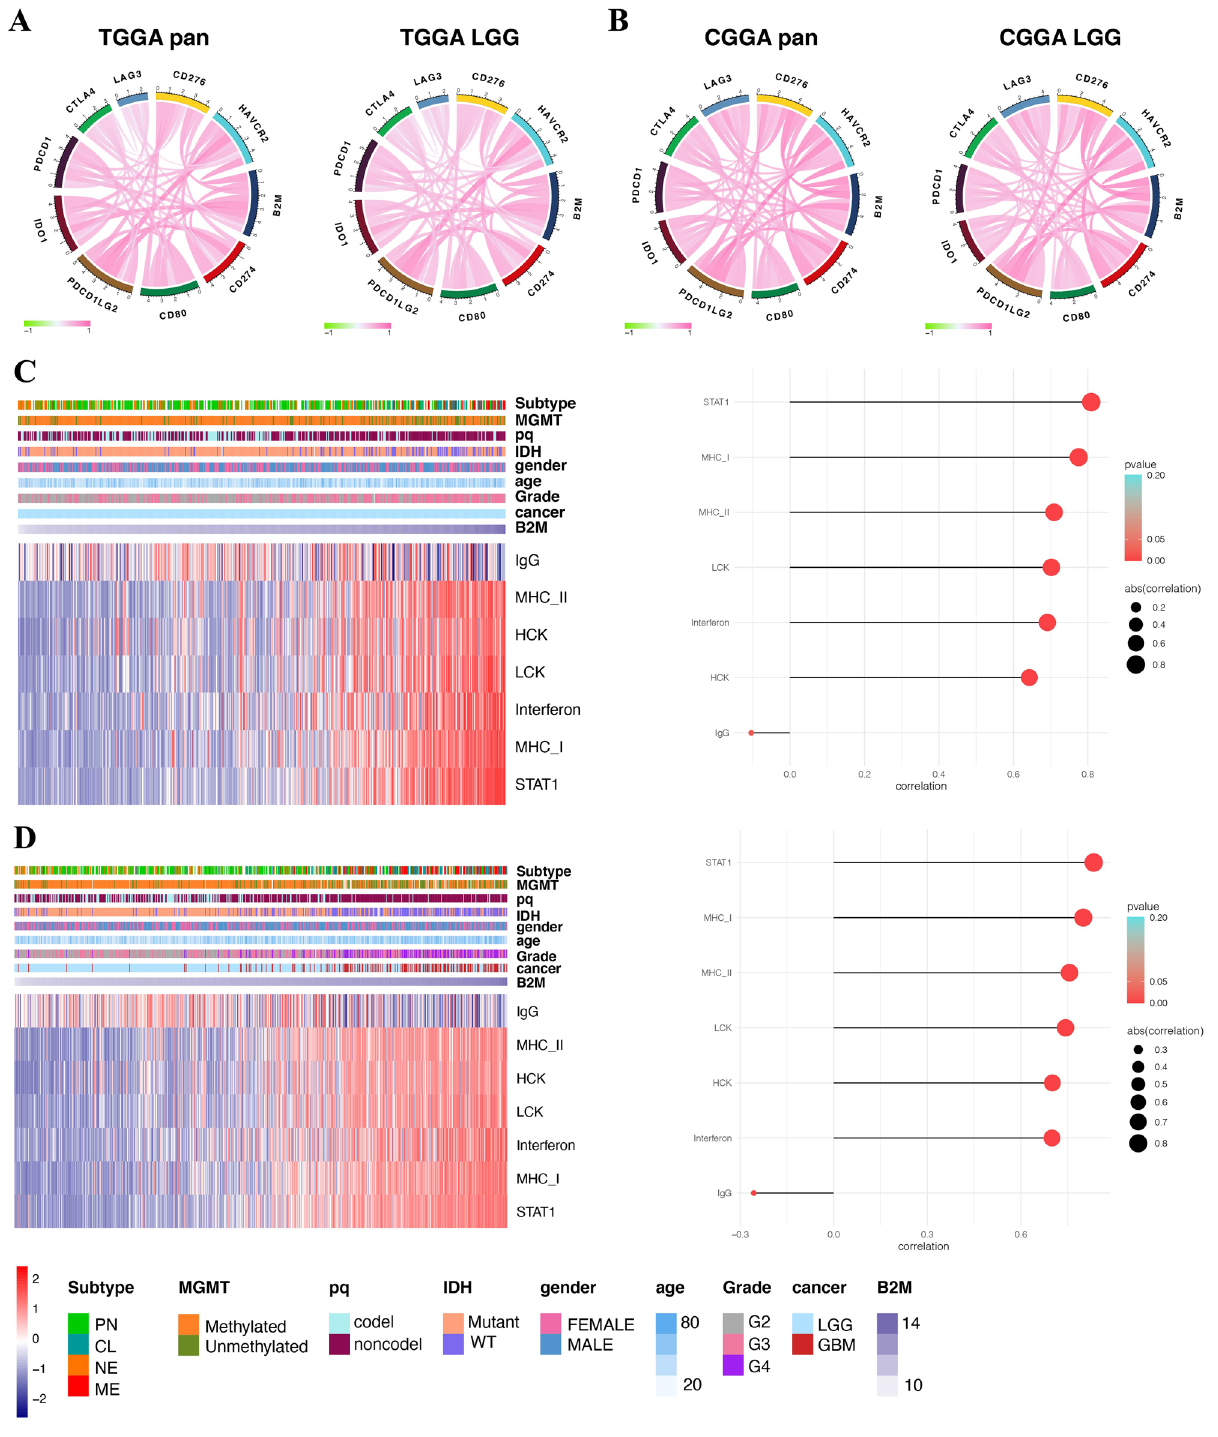
Figure 5. B2M correlates with immune checkpoint members and inflammatory activities in gliomas. B2M is relevant to other immune checkpoint molecules in pan-gliomas and LGGs from TCGA ( A ) and CGGA ( B ). Heatmaps illustrate the relationship between B2M and inflammatory activities in LGGs ( C ) and pan-gliomas ( D ) from TCGA. Expression values of B2M are z-transformed and are colored red for high expression and blue for low expression, as indicated in the scale